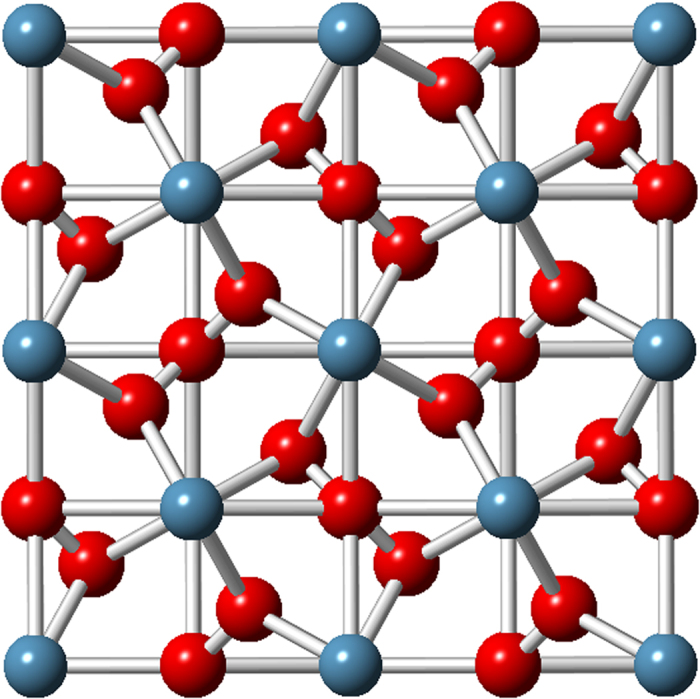
Crystal structure CaO3.Large blue spheres –Ca atoms, small red spheres – O atoms.